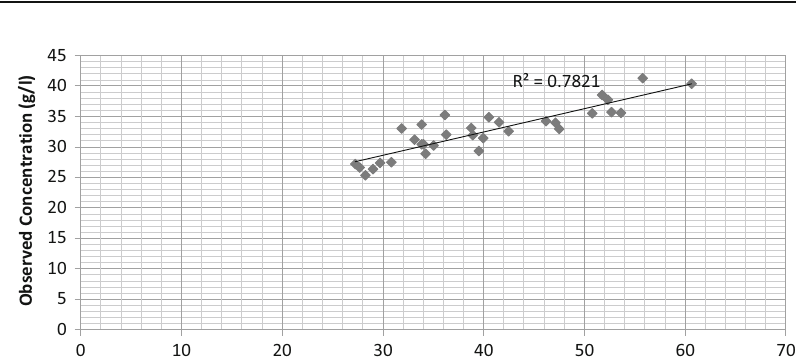
Fig. 3 The regression between CO concentration in modelling and field measurement- winter